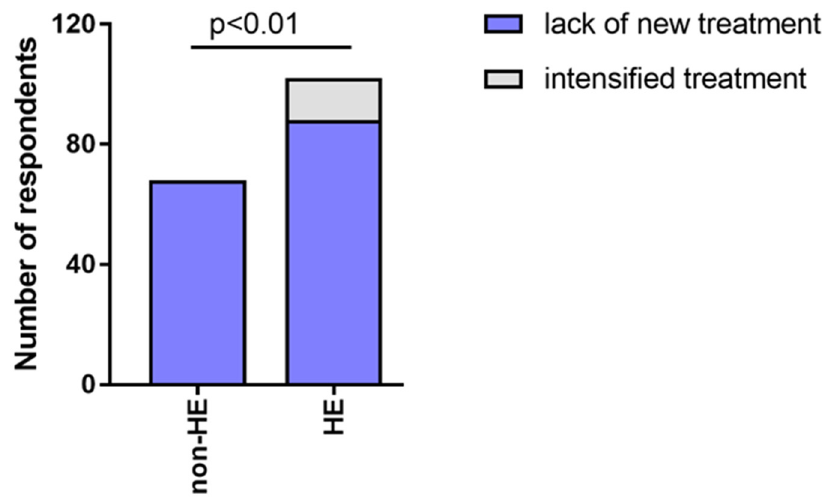
Figure 15. Changes in treatment in the HE-study group and non-HE group during pandemic.